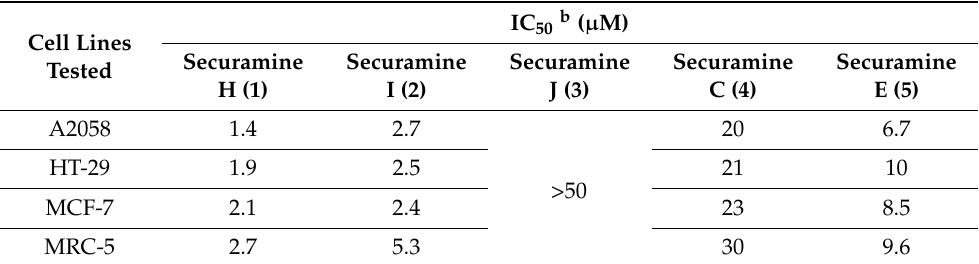
Figure 1. Chemical structure of securamine H ( 1 ), I ( 2 ), J ( 3 ), C ( 4 ) and E ( 5 ). Table 1. Cytotoxicity of securamines, isolated from the marine organism S. securifrons a , toward cancer cell lines and the nonmalignant cell line MRC-5